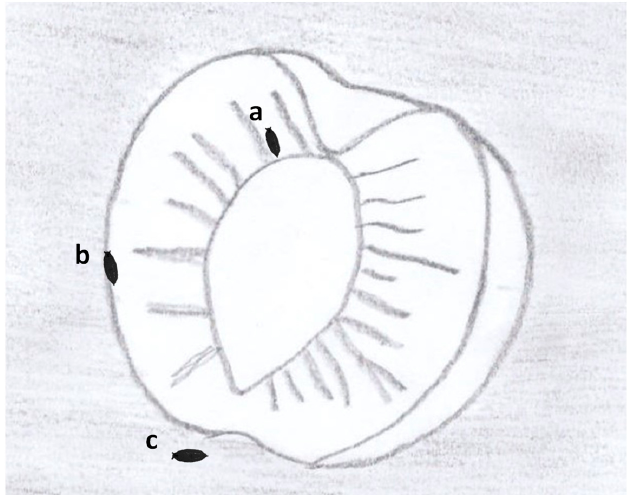
Figure 2. Scheme of a peach fruit fallen on the soil showing three microhabitats, in which the larvae of both saprophytic Drosophila spp. and Drosophila suzukii can pupate: (a) “inside fruit flesh”, (b) “outside fruit flesh” and (c) “soil”.